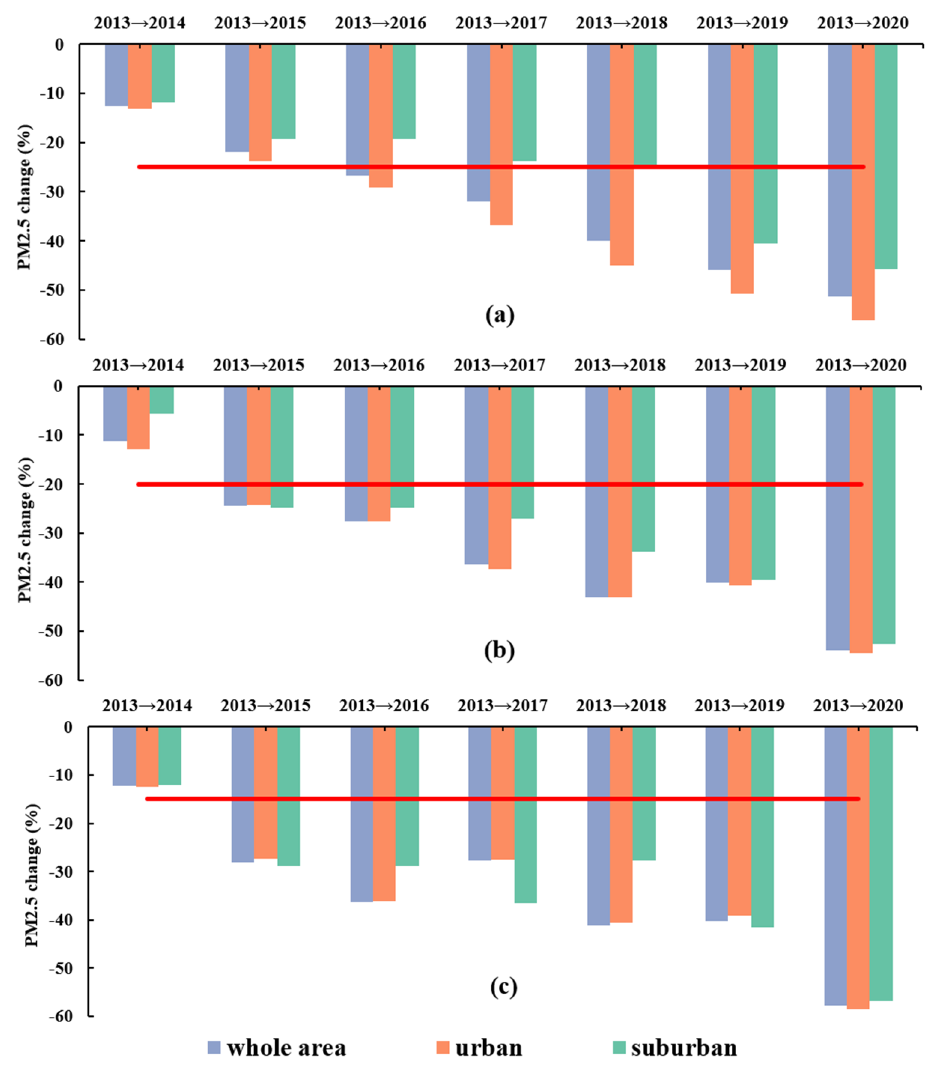
Figure 4. The percentage of PM 2.5 concentration change in urban and suburban areas and the region as a whole for BTH ( a ), YRD ( b ), and PRD ( c ) since 2013. The red lines show the targets specified in the Air Pollution and Control Action Plan for each urban